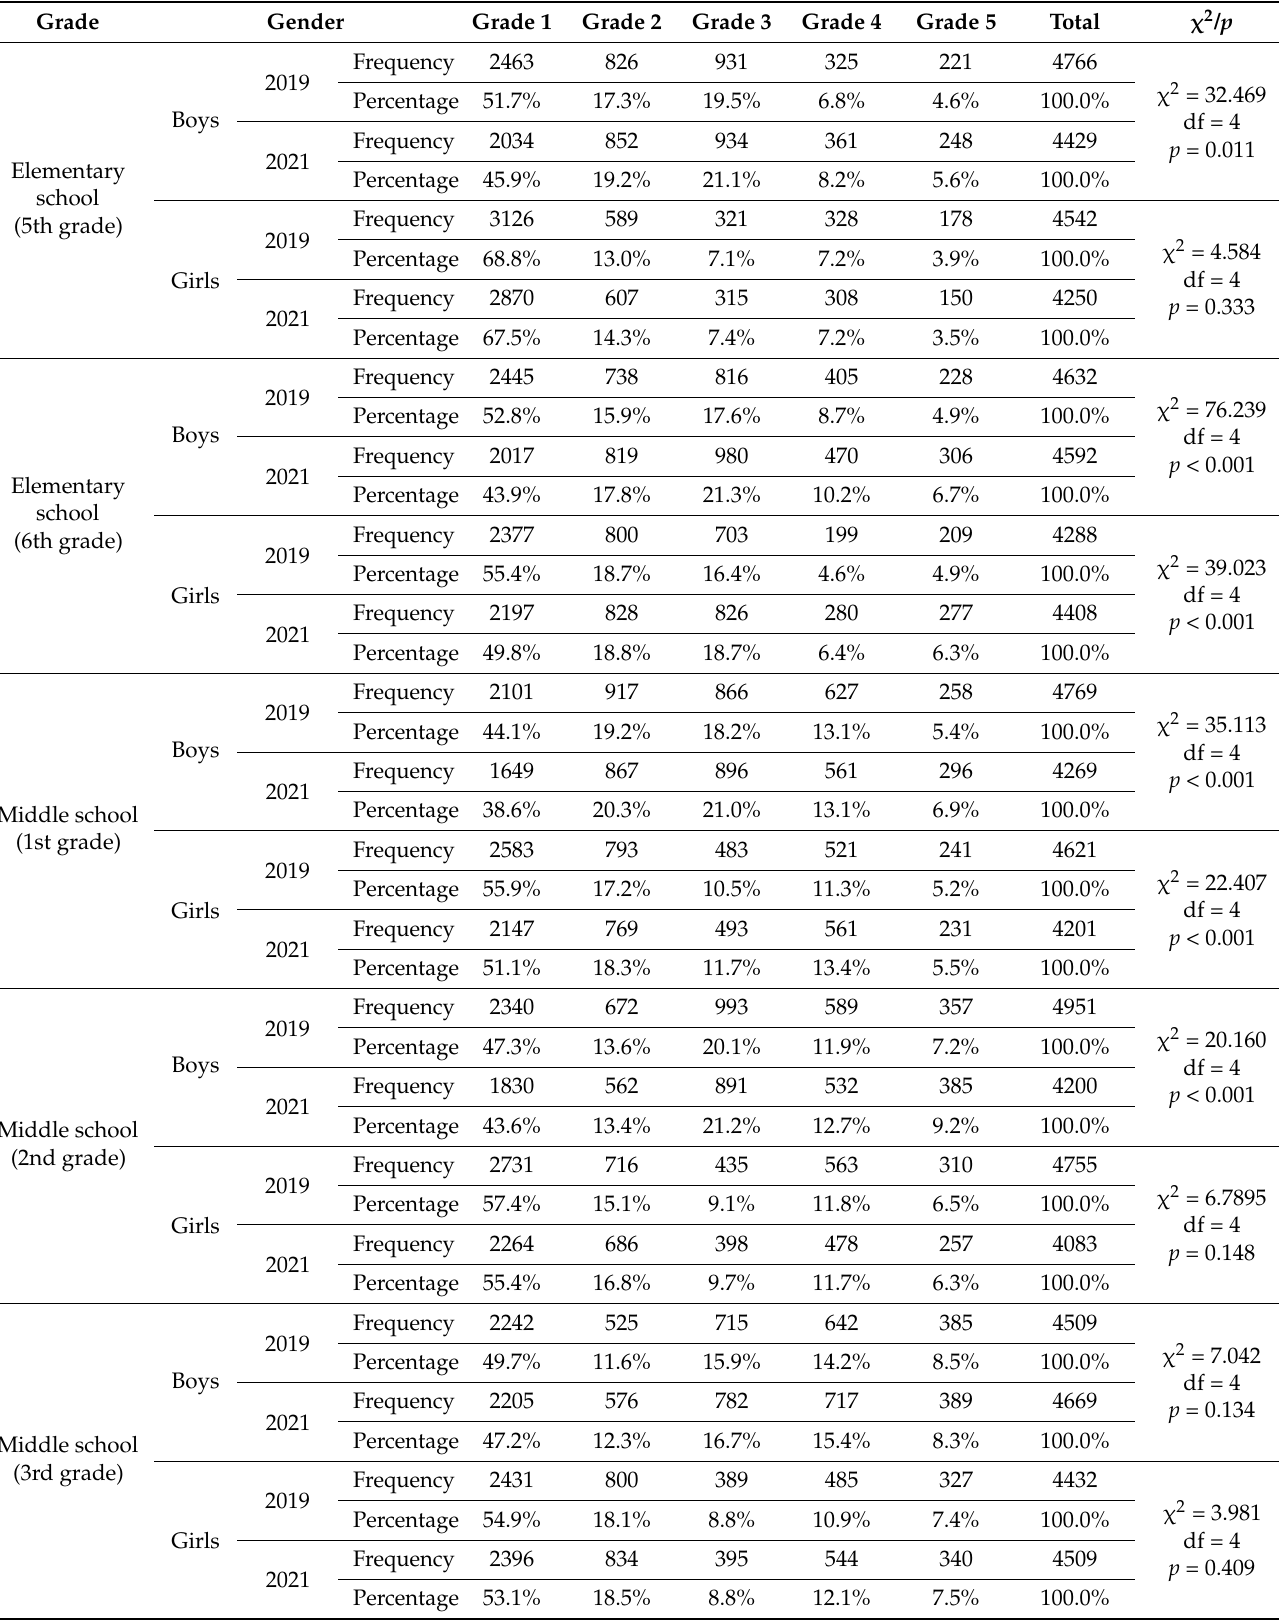
Table 6. Comparison of flexibility in 2019 and